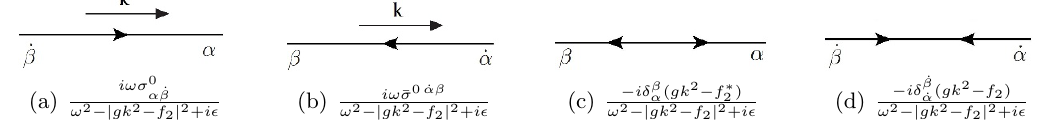
Figure 3 . Feynman diagram representation for the fermionic propagators. These correspond to equations (3.55){(3.58). In these conventions, arrows on fermionic lines are always directed away from dotted indices or towards undotted indices at a certain vertex. It should be noted that the choice between (cid:12)gures 3(a) and 3(b) is made in accordance with the index contraction order chosen for the corresponding fermionic line in the full diagram, and the direction in which the propagator appears in it. In the diagrams here the index order is assumed to be taken from right to left, matching equations (3.55) and (3.56).